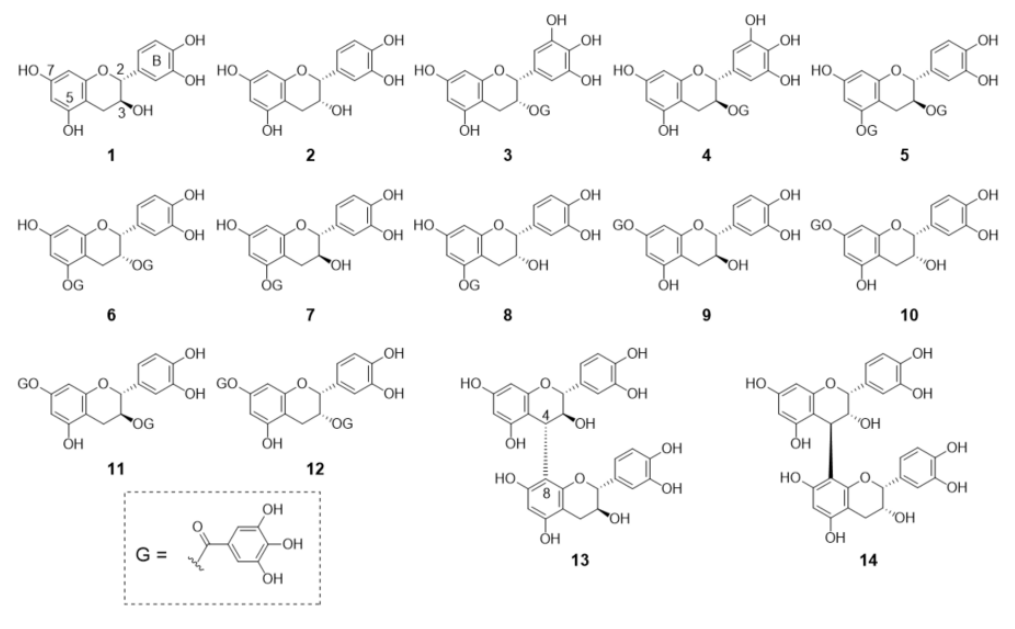
Figure 1. Chemical structures of flavan-3-ol derivatives adsorbed on gelatin.